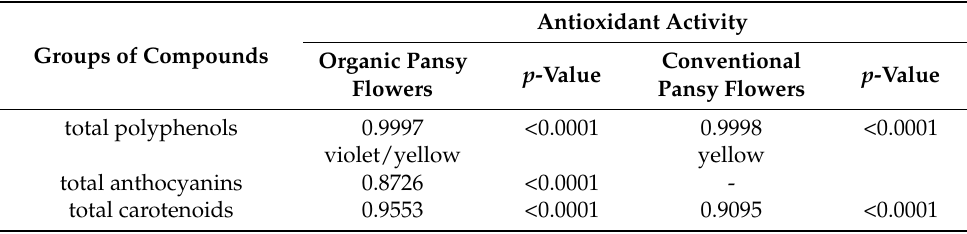
Table 3. Pearson’s coefficient (R 2 ) between antioxidant activity and total polyphenols, anthocyanins, and carotenoids in organic and conventional pansy flowers with different